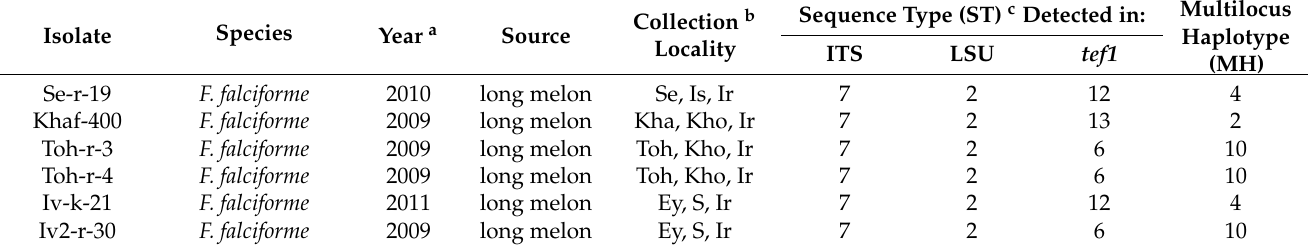
Table 1. FSSC isolates recovered from melons in Iran, their host and geographic area of origin, date of isolation, and multilocus haplotypes (MHs) and sequence types (STs) based on the partial sequences of three gene regions (ITS, LSU, and tef1